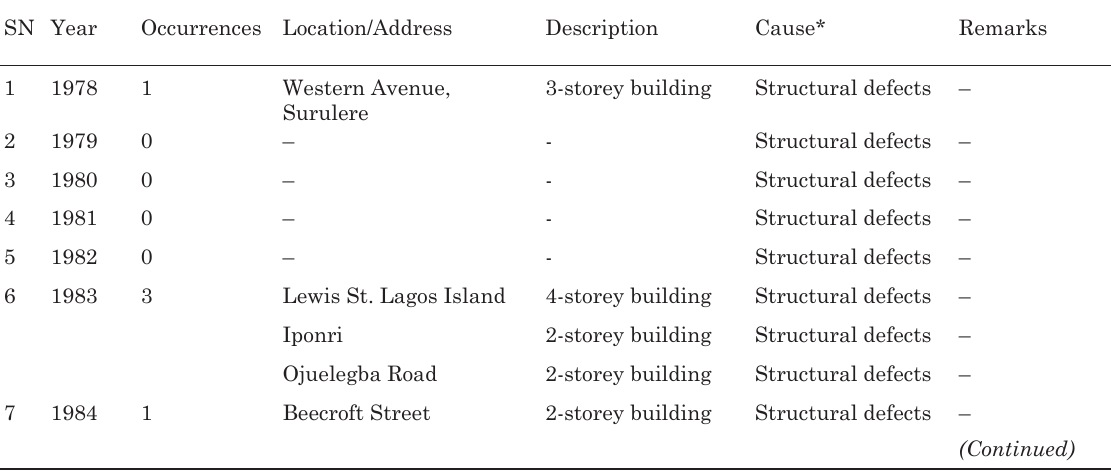
table 1. details of collapsed buildings in lagos metropolis